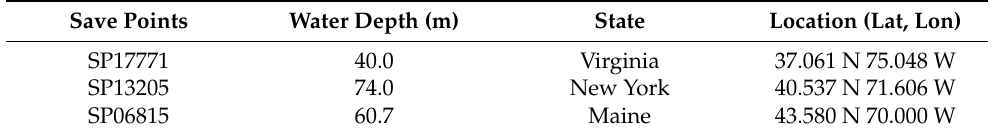
Table 1. The index number, water depth, and location information for the selected three save points in the NACCS storm surge